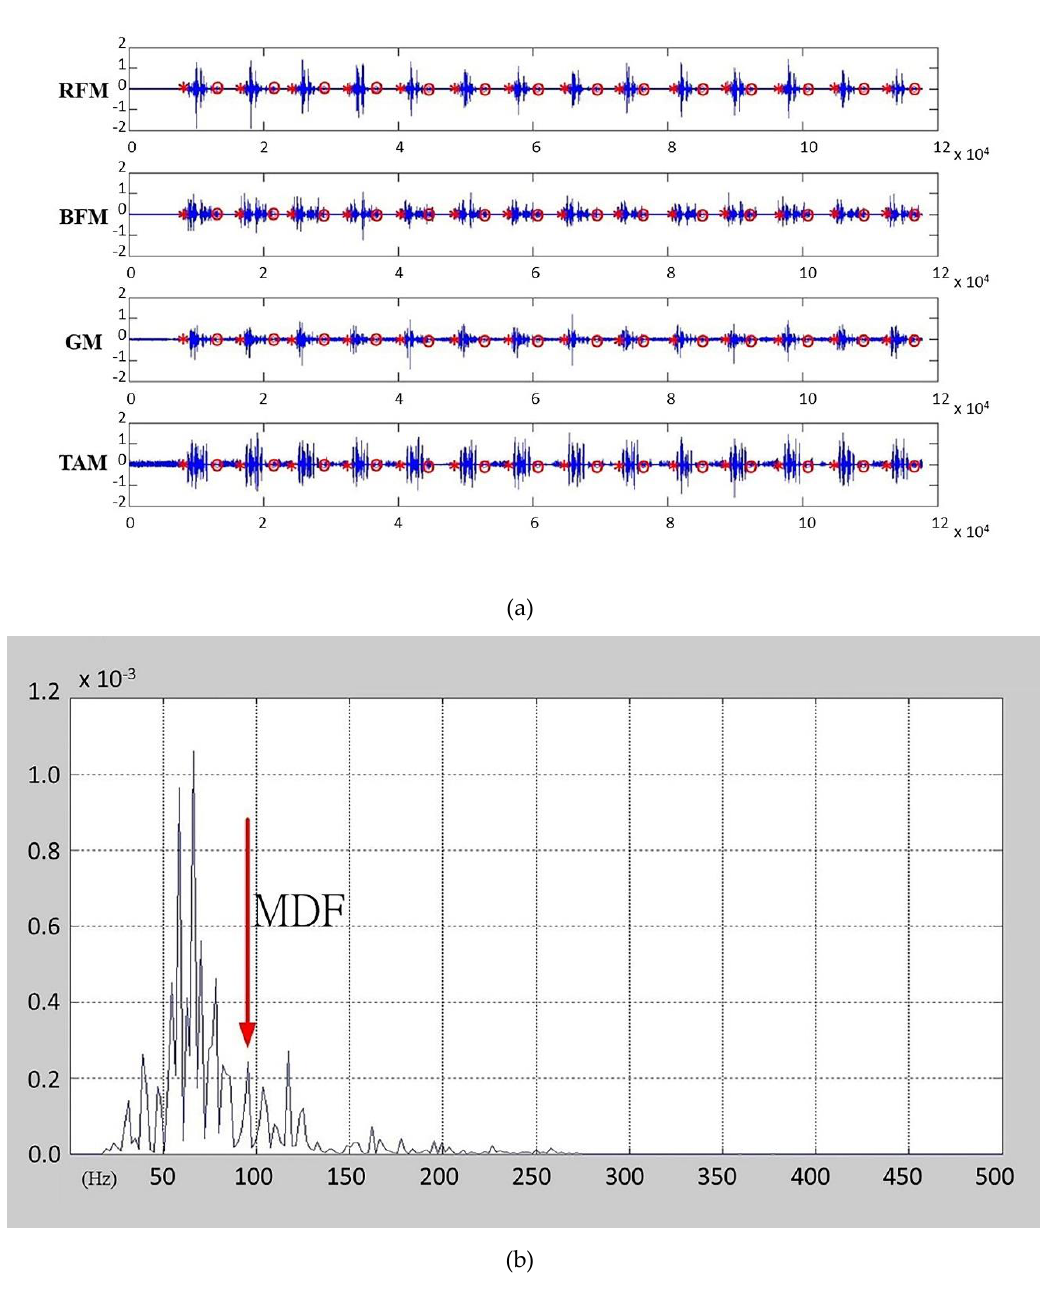
Figure 2. The signals of surface electromyographic activity and the results of median frequency (MDF) on the lower extremity muscles. ( a ) The EMG signals for the rectus femoris (RFM), biceps femoris (BFM), tibialis anterior (TAM), and the gastrocnemius (GM) during the blocking jumps. The time series of the EMGs were captured and analyzed between the subject contact “*” with the force-plate and when it leaves “o”. ( b )The median frequency of the signal spectrum.